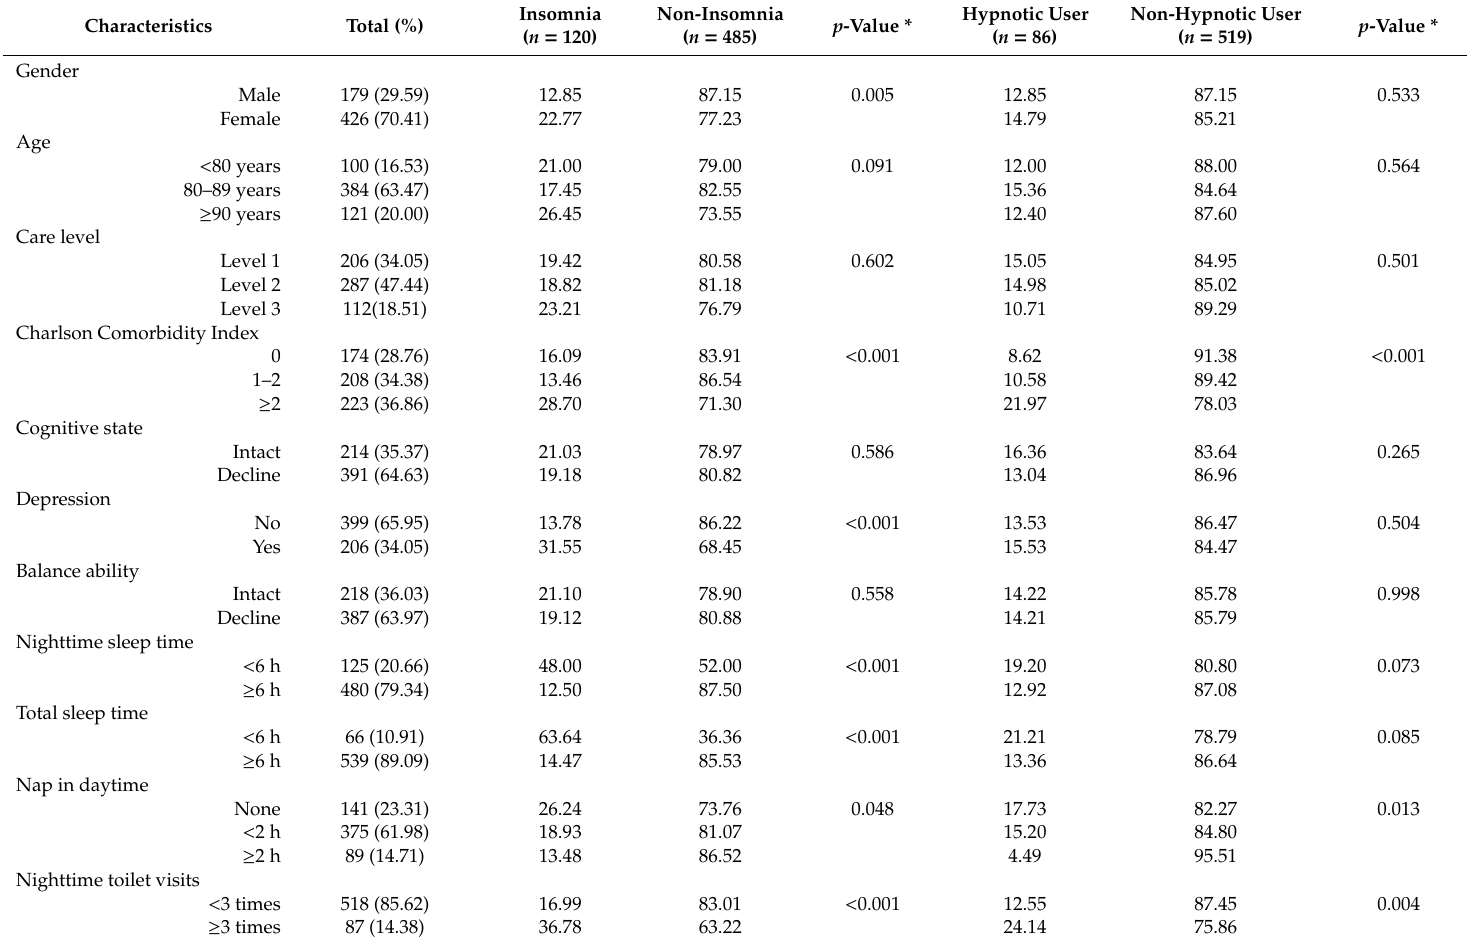
Table 1. Characteristics of the study participants by sleep quality and hypnotics use ( n =